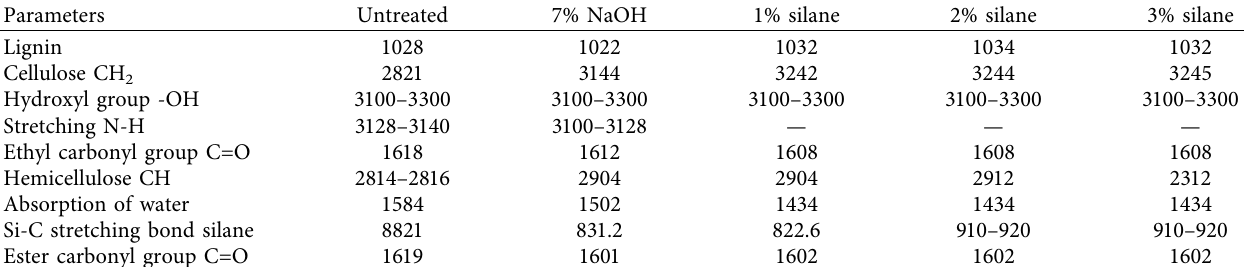
Table 5: Extrusion parameters.